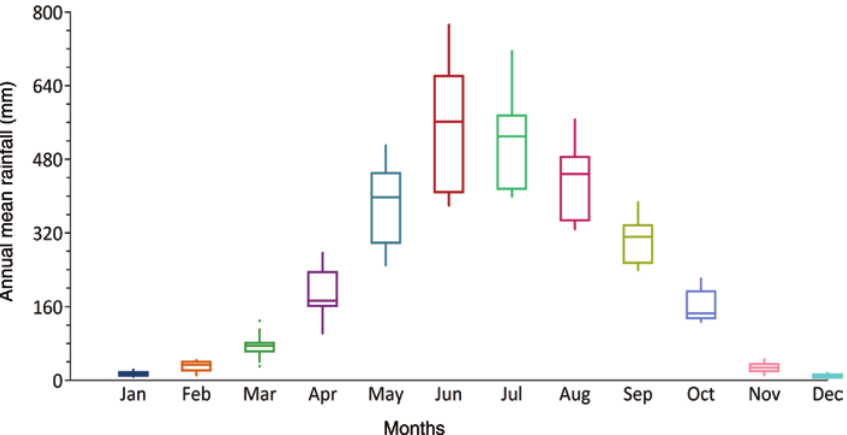
Figure 2: Box Plot Showing Annual Mean Rainfall at All Stations for Every Month Between 1901 and